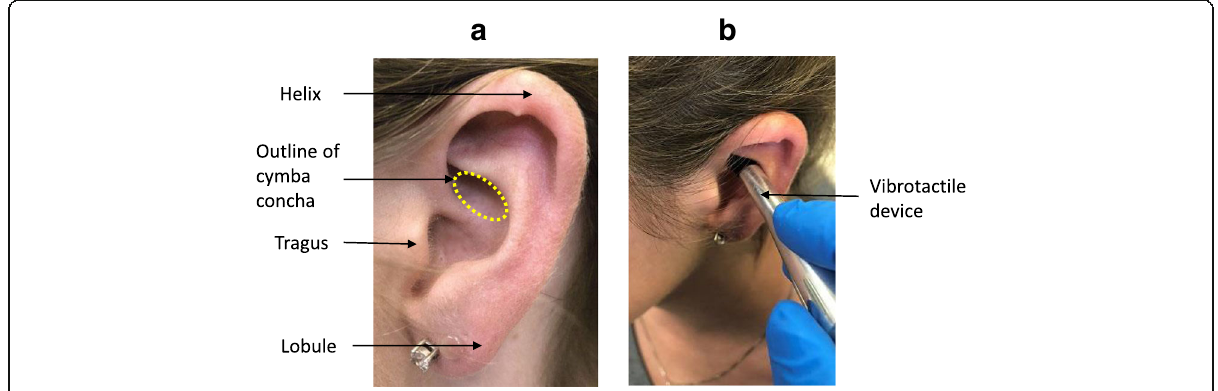
Fig. 1 Site of application of vibrotactile device to the cymba concha of the ear. ( a ) Major anatomical landmarks of the external ear (pinna) with approximate outline of the cymba concha. The cymba concha is a highly-conserved anatomical feature of the external ear that was identified by the device operator. ( b ) Representative device placement of the vibrotactile device in contact with the cymba